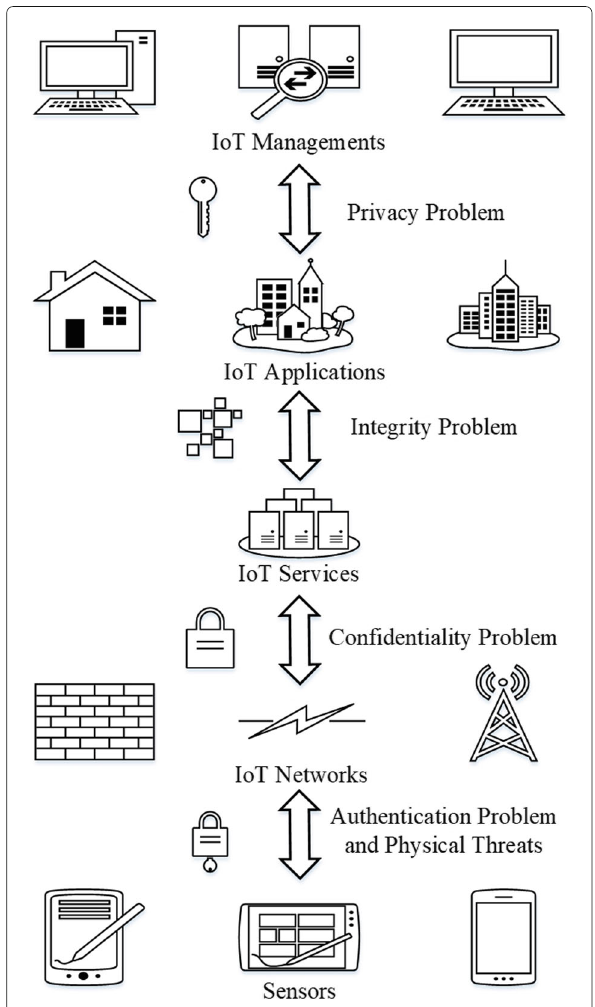
Fig. 4 The security challenges in the different IoT layers. The four types of security problems arising in the IoT model are